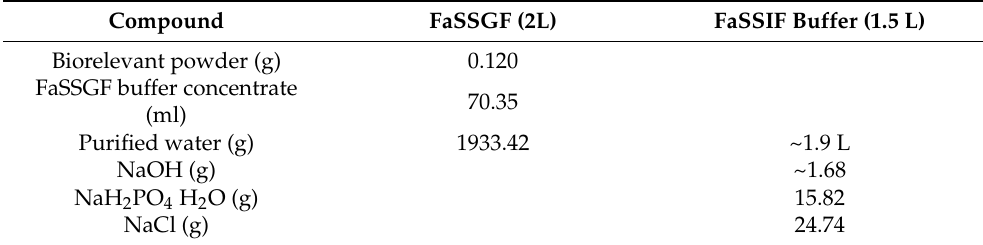
Table 4. Composition of FaSSGF biorelevant dissolution media and FaSSIF buffer.